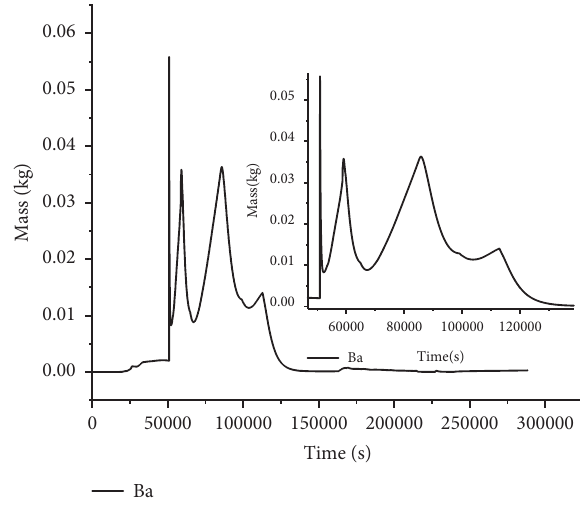
Figure 13: Release of Ba in the primary circuit system.